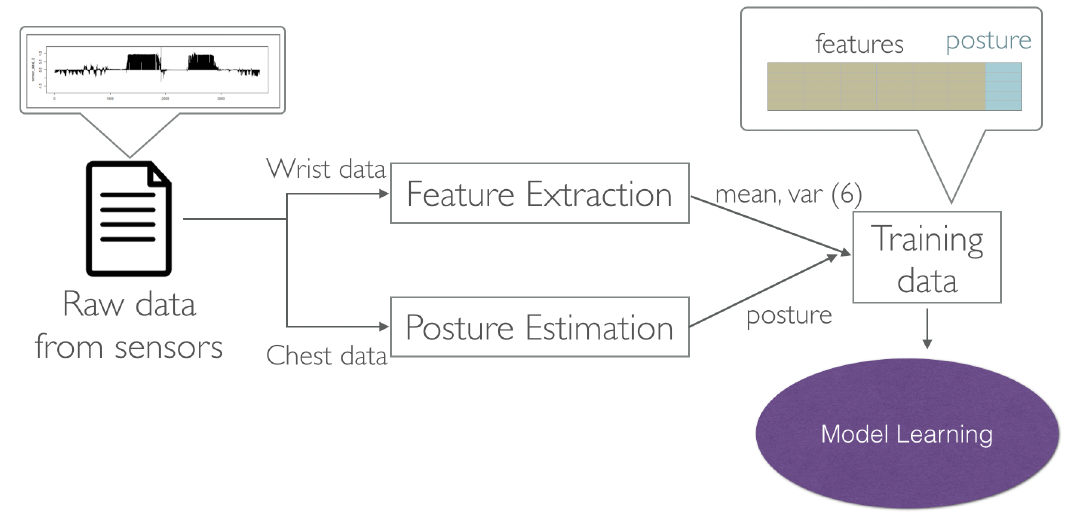
Figure 8. Model training process in the system. The training data and the label data are collected by the smartphone, and then sent to the server for training personal model for posture